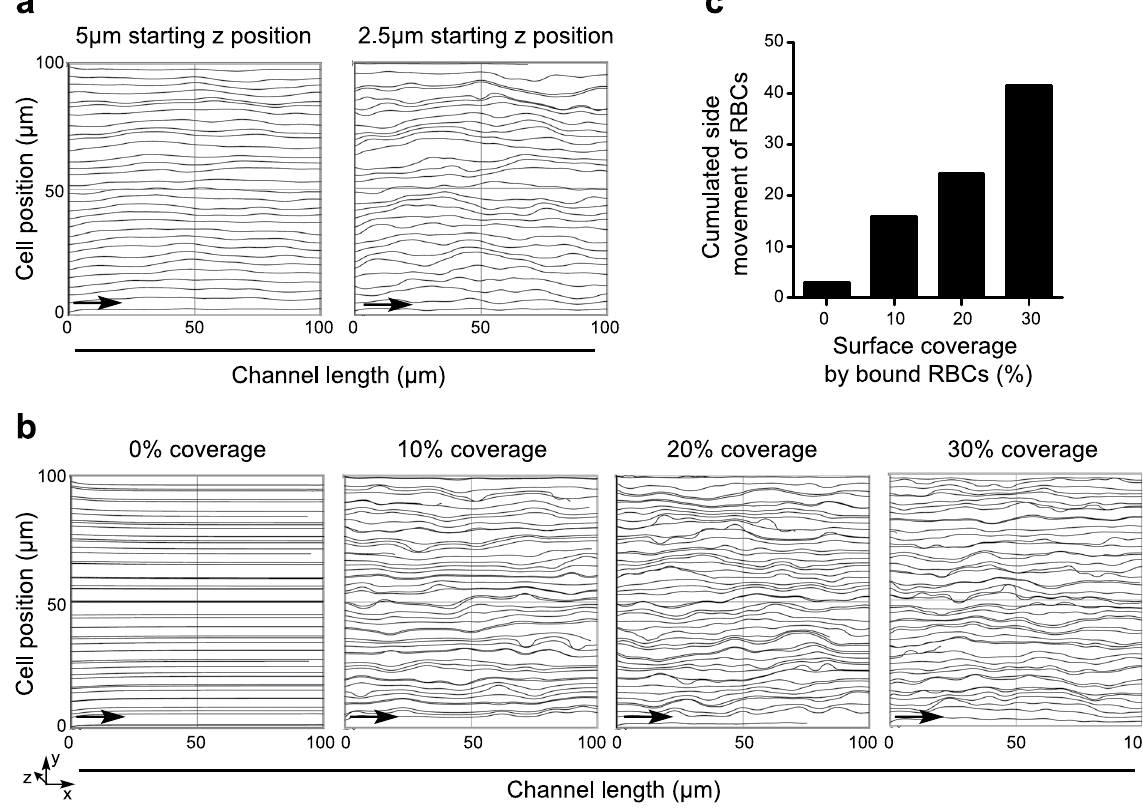
Figure 4. ( a ) Lateral projection of the FEM modelled RBC trajectories over the trapped cells in case of 5 μ m and 2.5 μ m starting z position. Arrows indicate the direction of simulated flow. ( b ) Simulated particle trajectories over the functionalized area of the microfluidic system in case of different trapped cell coverage on the surface of the 100 × 100 μ m 2 area. ( c ) Cumulated side movement (in y and z directions) of the RBCs crossing the functionalized area covered by bound cells (FEM